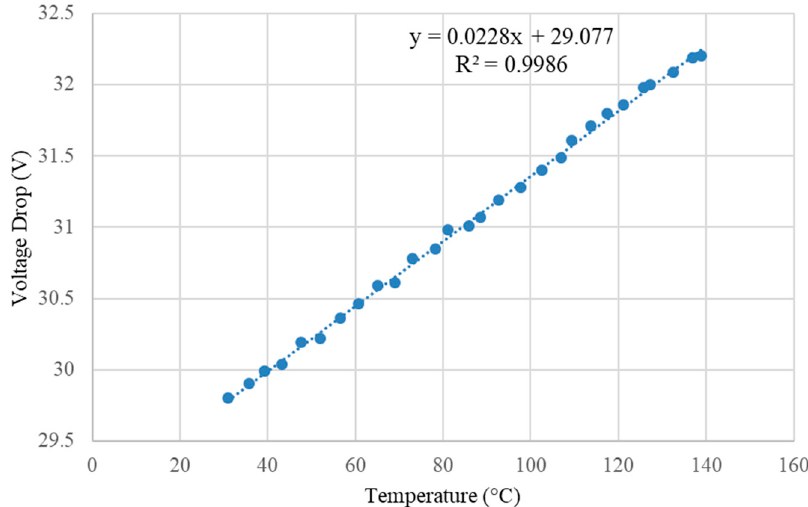
Figure 7. Measured voltage drop of the combined Zener diodes over the temperature range of 30 to 140 °C. A negative supply voltage of 32.61 V and a 10 k Ω biasing resistor was used. A linear line of best fit (dotted blue line) has been added to estimate the temperature dependance and voltage drop of the combined Zener diodes at 0 °C. Voltages were measured to ±0.01 V accuracy, and temperature was measured to ±1 °C accuracy.